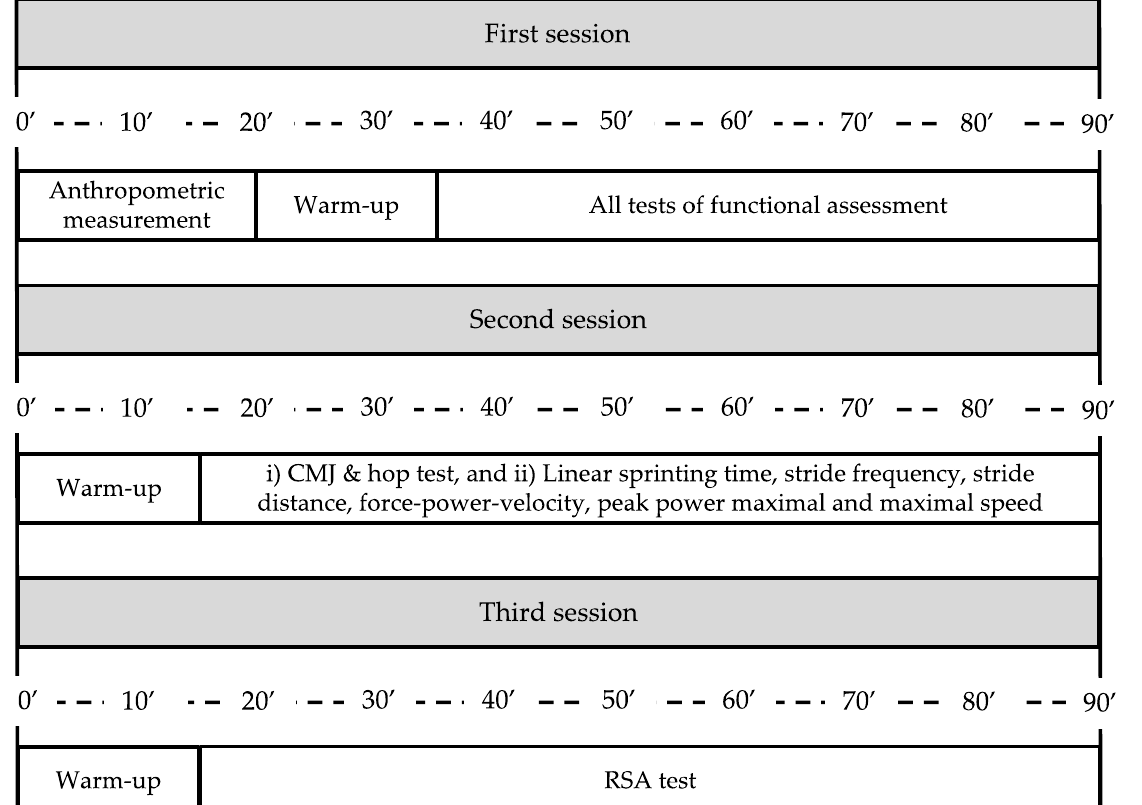
Figure 1. Schematic representation of study (see text for full description).